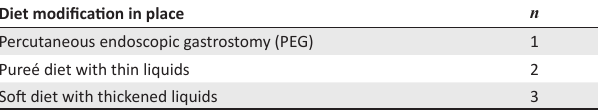
TABLE 2: Diet modifications that were being used at